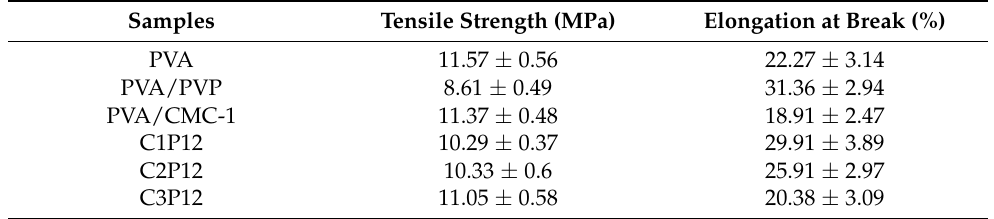
Table 3. Tensile strength and elongation at break of PVA, PVA/PVP, PVA/CMC, and tricompo- nent